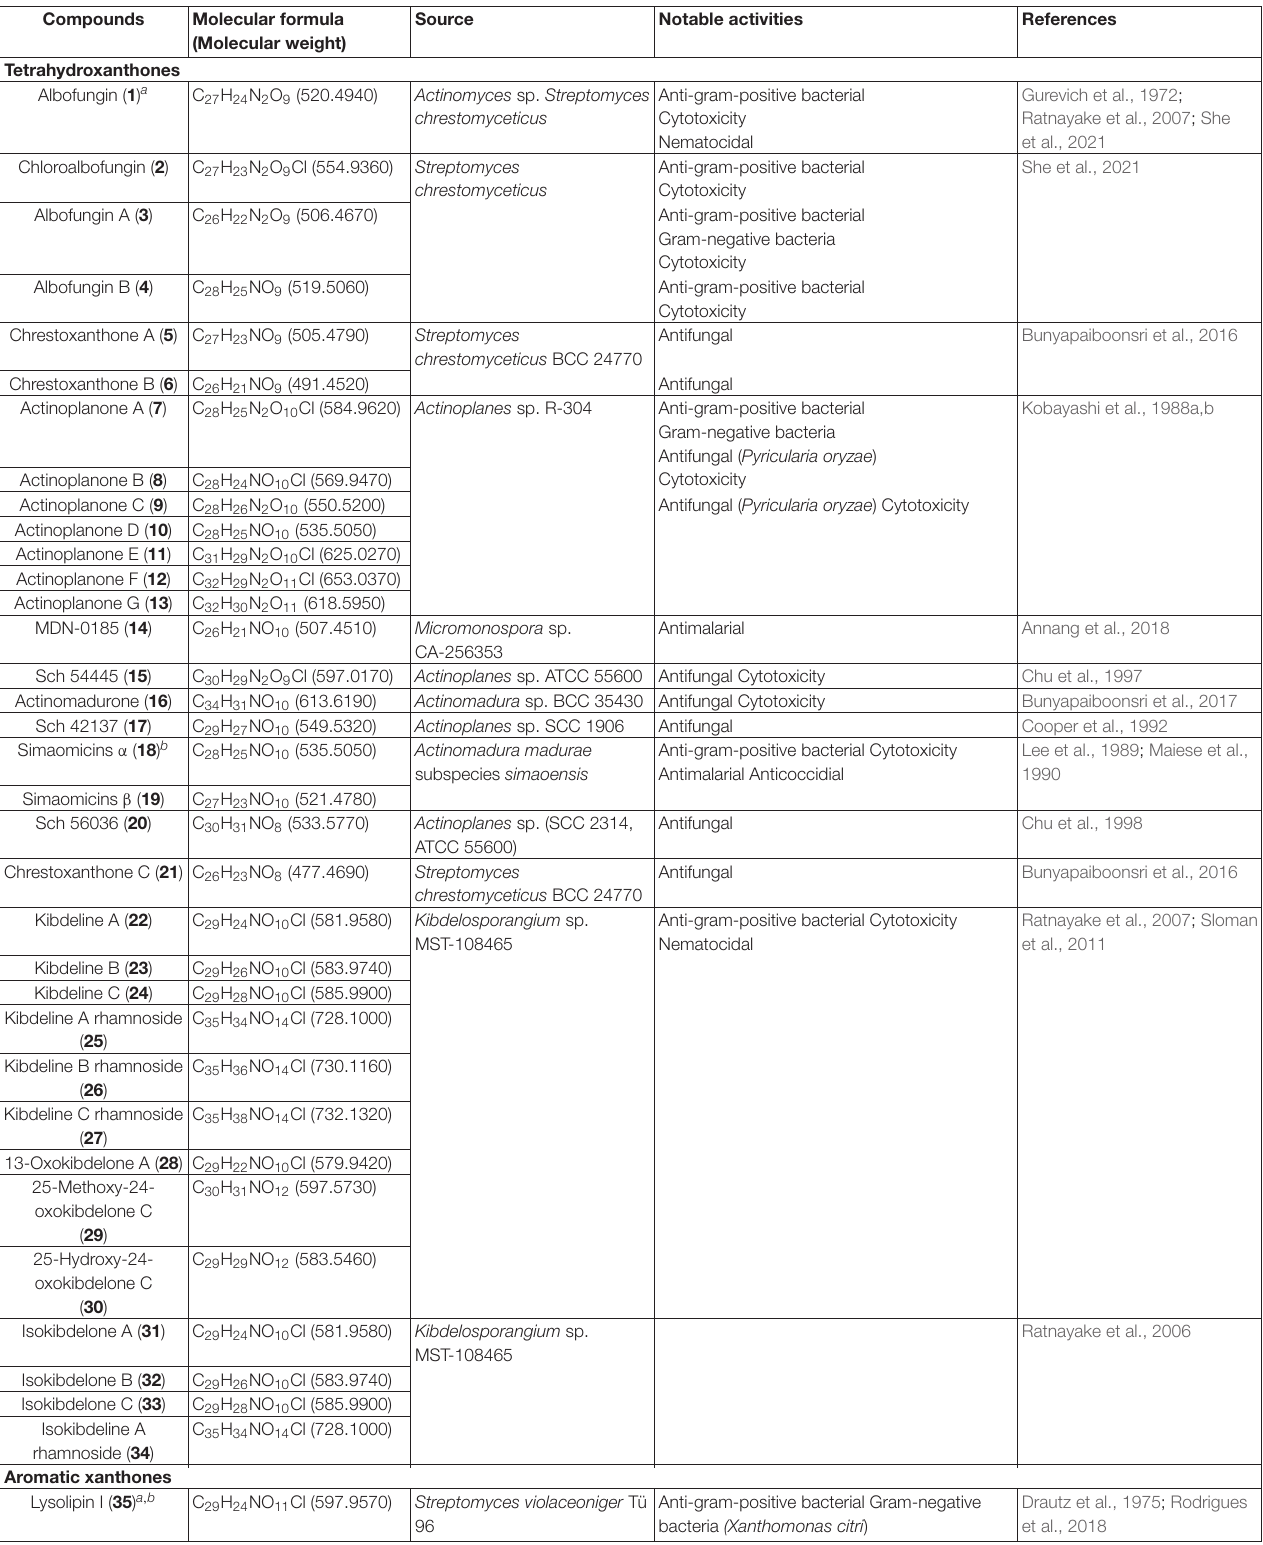
TABLE 1 | Structurally diverse polycyclic xanthones from